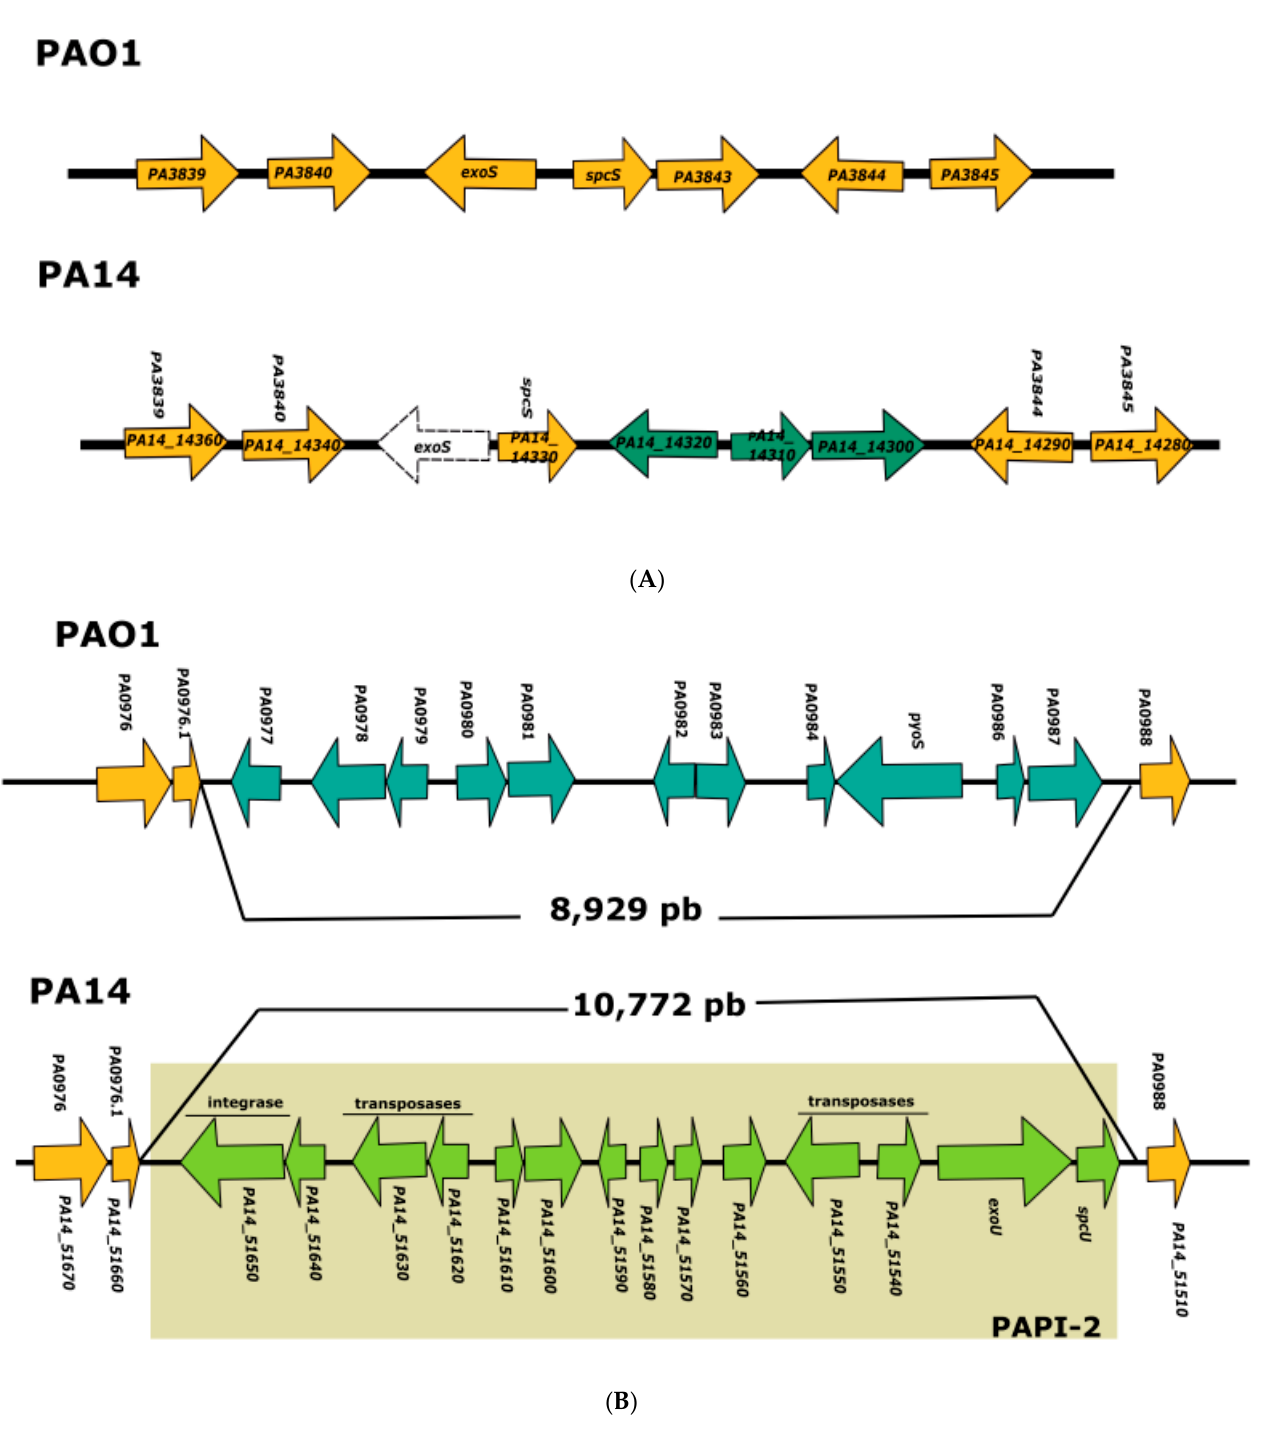
Figure 1. Analysis of PAO1 and PA14 genome regions where exoS and exoU are encoded. ( A ) Representation of the PAO1 and PA14 chromosomal regions where exoS is encoded in the former strain; homologous genes are shown in orange; PA14_14300, PA14_14310, and PA14_14320 genes that are present only PA14 chromosome are shown in green, and the deletion of exoS in PA14 is shown by a dotted line. ( B ) Representation of the PAO1 and PA14 chromosomal regions where exoU is encoded in the latter strain; homologous genes are shown in orange, genes corresponding to PAPI-2 pathogenicity island are shown in green, and genes corresponding to the 8.9 kb PAO1 ge- nomic island are shown in blue.